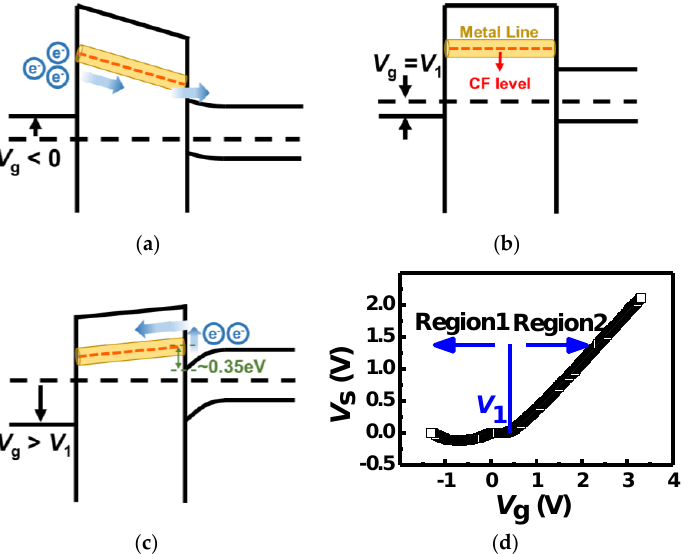
Figure 5. Energy band diagram of current transmission at ( a ) region 1, ( b ) region 2, ( c ) V g = V 1 . ( d ) V s - V g curve. ( V s : the voltage dropped on Ge substrate; V g : the voltage applied on the gate.).